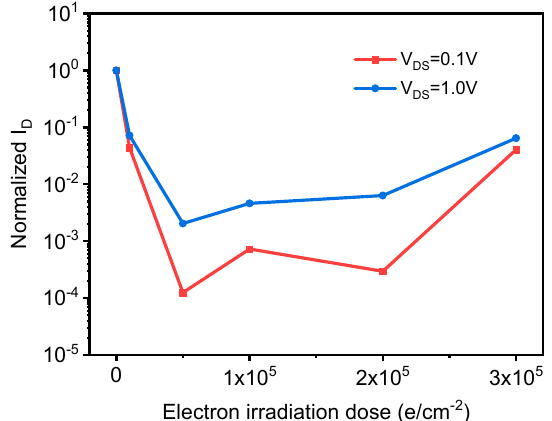
Figure 13. The normalized leakage current of graphene samples varies with the dose of electron irradiation.